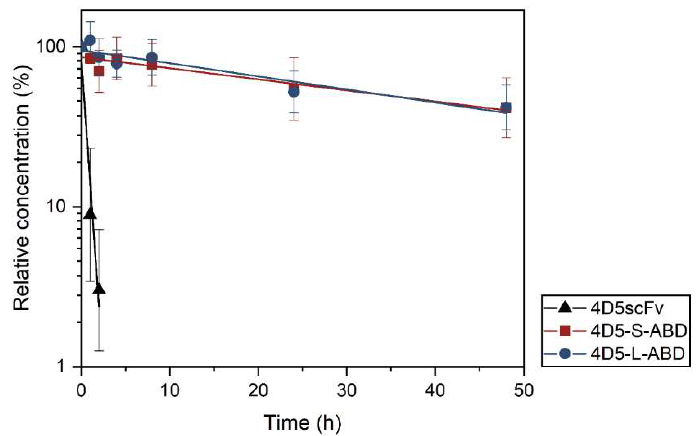
Figure 5. Pharmacokinetic profiles of 4D5scFv and two 4D5-ABD variants. Table 2. Pharmacokinetic parameters of 4D5scFv and two 4D5-ABD variants. 4D5scFv Variant